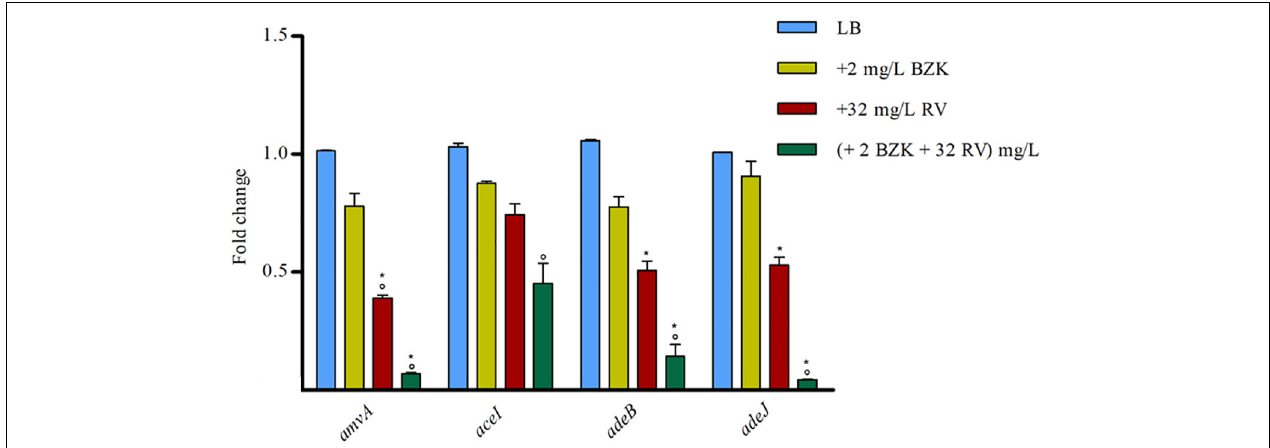
FIGURE 6 | RT-qPCR assay of amvA , aceI , adeB, and adeJ genes expression in the absence (LB) or presence of 2 mg/L BZK alone or in combination with 32 mg/L RV. Relative number of transcripts of each gene was normalized in each condition and calculated using the 2 - (cid:49)(cid:49) ct method compared to the expression level in LB control. The mean ± standard deviation of relative number of transcripts is shown for each gene. All experiments were performed in triplicate. P -values were calculated using ANOVA (* p < 0.01 vs. LB; ◦ p < 0.01 vs. 2 mg/L